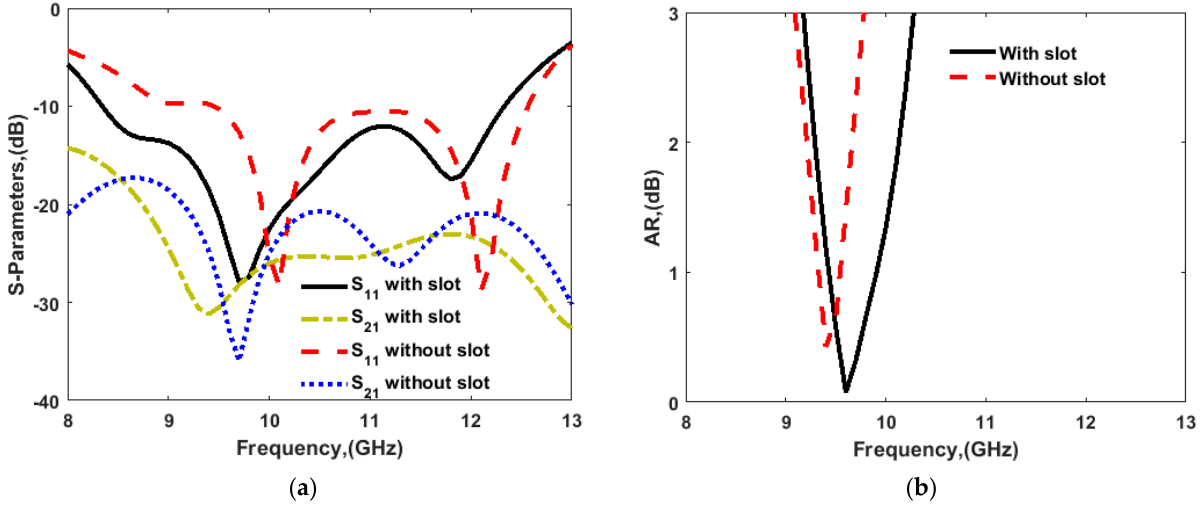
Figure 6. Two-element CP MIMO DRA ( a ) without and ( b ) with DGS.